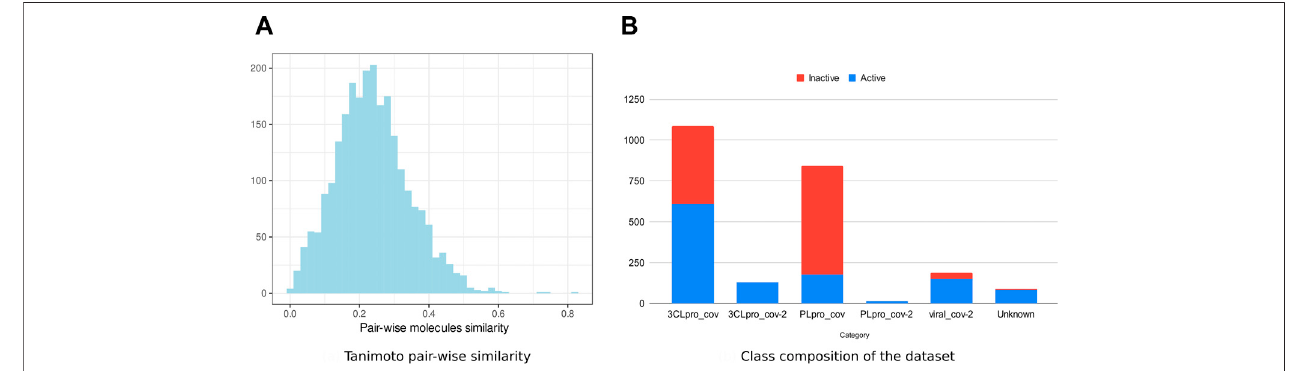
FIGURE 1 | Anticoronavirus dataset composition. (A) Distribution of the pairwise chemical similarity among the molecules based on the Tanimoto coef fi cient. (B) Proportions of “ active ” and “ inactive ” molecules within each experimental category.